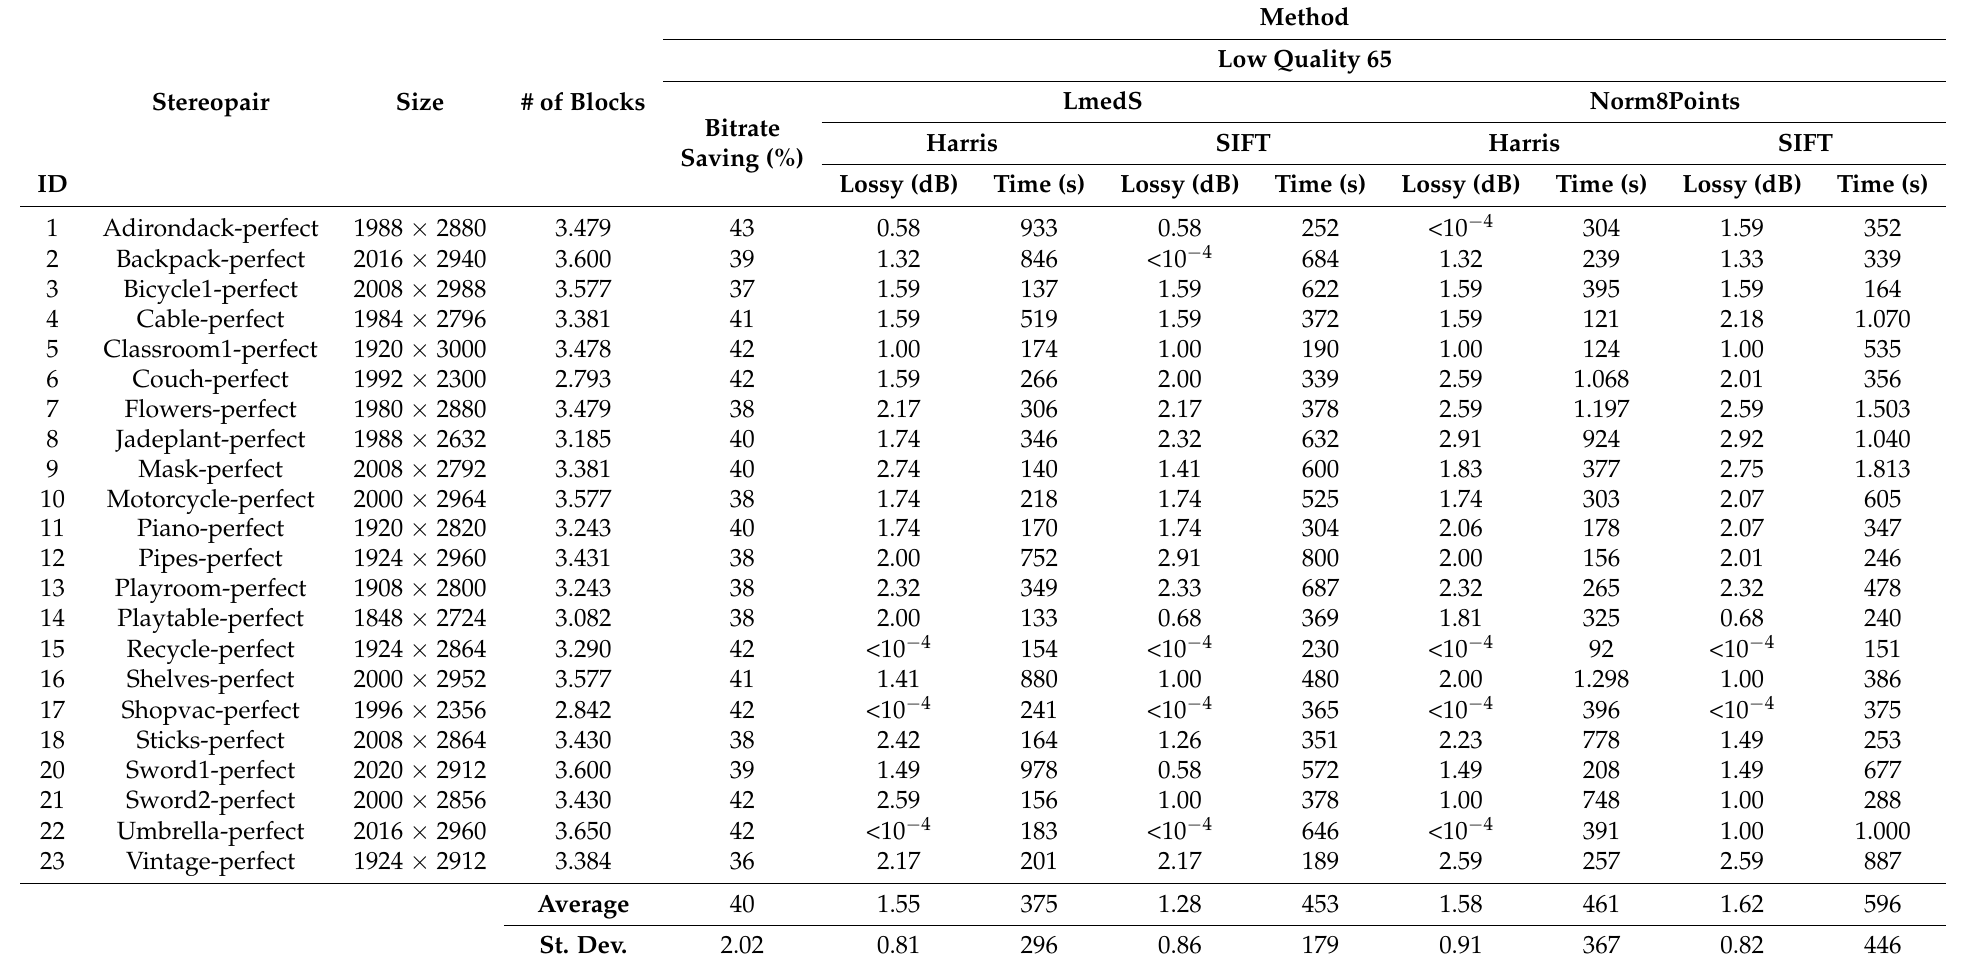
Table 2. Results on the Middlebury-scenes 2014 dataset, considering a low quality of